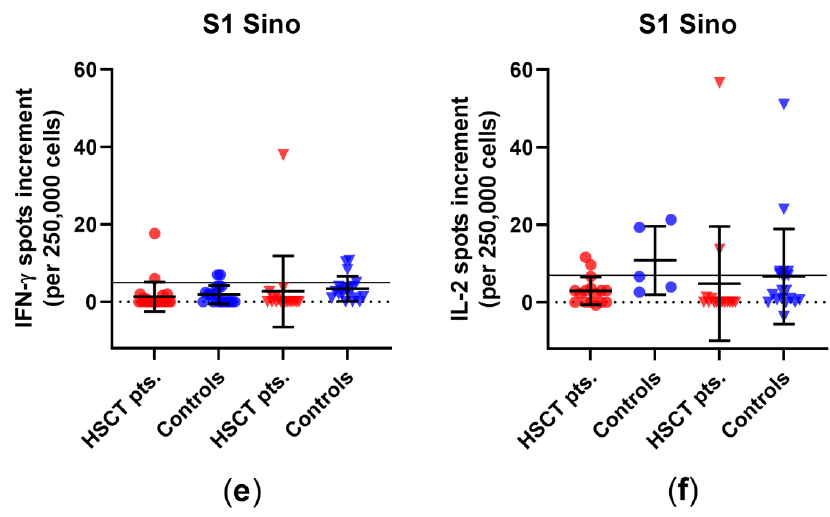
Figure 2. SARS-CoV-2-specific ELISpot responses in HSCT patients and healthy controls before and after third vaccination. Distribution of ( a ) IFN- γ and ( b ) IL-2 ELISpot responses upon stimulation with an S1/S2 peptide mix. Distribution of ( c ) IFN- γ and ( d ) IL-2 ELISpot responses upon stimulation with an S1 peptide mix. Distribution of ( e ) IFN- γ and ( f ) IL-2 ELISpot responses upon stimulation with S1 Sino. Please note that the scales differ. Circles indicate data before the third vaccination (red—HSCT, blue—healthy controls), while triangles indicate data after the third vaccination. Responses were compared by two-tailed Mann–Whitney test. Horizontal lines indicate mean values, while error bars indicate the standard deviation. The dotted line represents the zero line. The black horizontal line indicates the cutoff.